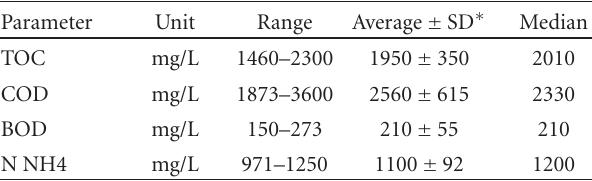
∗ SD:standarddeviation;numberofmeasurements n = 16;time-dependent variation of parameters value was caused by unstable composition of